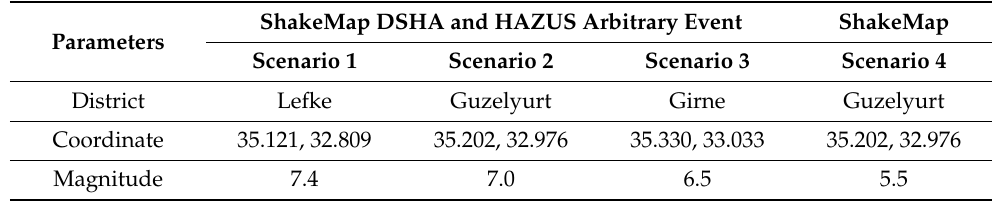
Table 6. Earthquake scenarios